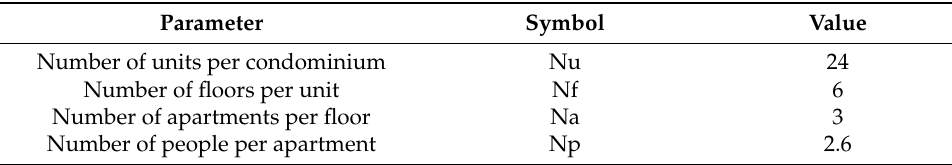
Table 1. Building and demographic characteristics of the condominium. Parameter Symbol Value Number of units per condominium Nu 24 Number of floors per unit Nf Number of apartments per